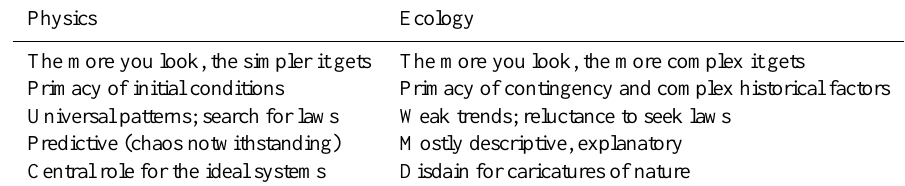
Table 1. Different world views of physicists and ecologists (mind sets) (from Harte, 2002).